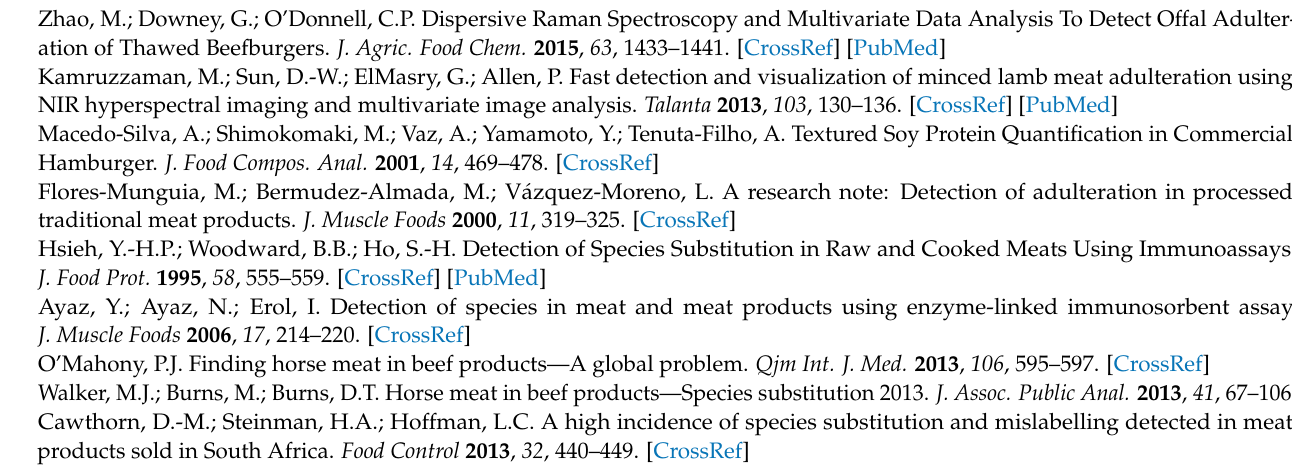
Table S3: Regulations regarding the classification and compositional specifications of raw beef patties; Table S4: An overview of the proximate chemical composition analysis results (means ± SD) for the moisture-, fat- and protein content (%) of the various